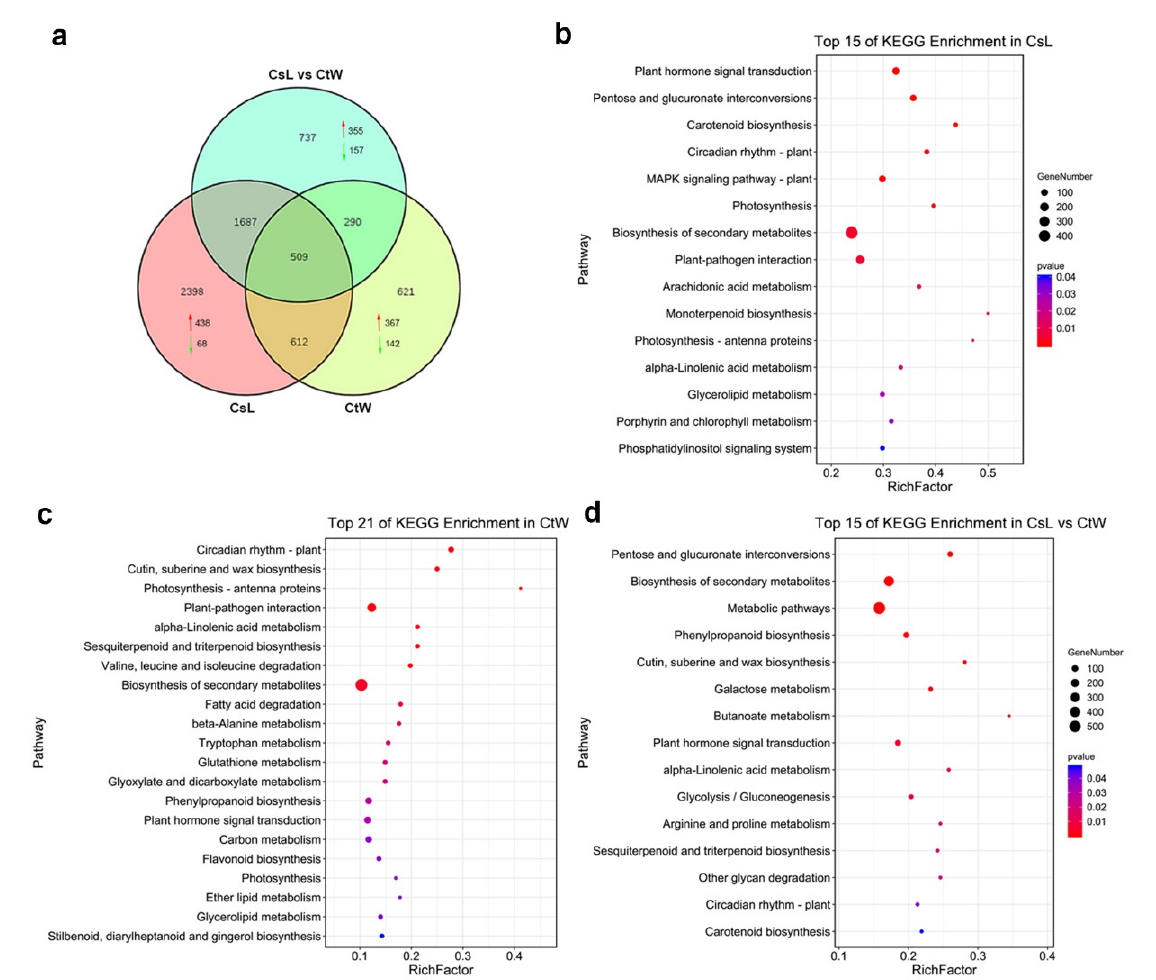
Figure 1. Venn diagram and significantly enriched KEGG pathways of differently expressed genes (DEGs) under freezing treatment. ( a ) Venn diagram showing the shared and specific number of up-regulated and down-regulated DEGs identified in CtW, CsL, and CtW vs. CsL. CtW: cold-tolerant ‘Weixuan 1’; CsL: cold-sensitive ‘Longwangmao’. ( b , c ) Significantly enriched KEGG pathways of DEGs in CtW ( b ), CsL ( c ), and CtW vs. CsL ( d ).